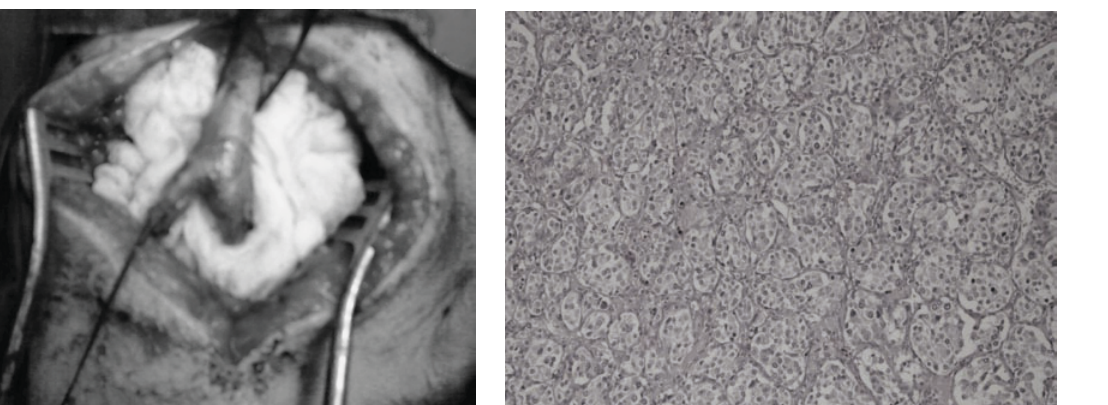
Figure 4. After operation, the carotid arterial system.